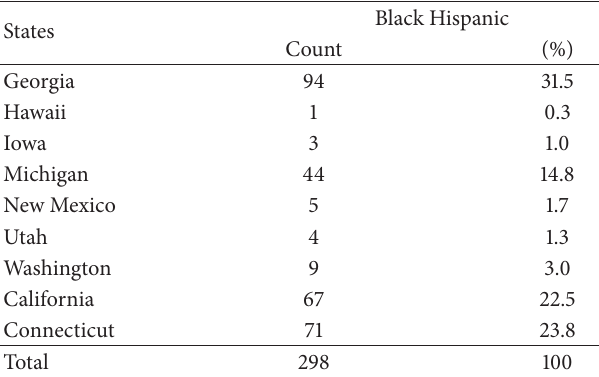
Figure 2: The nine states from which the Black Hispanic breast cancer patients were selected. Note . The Black Hispanic females ( 𝑛 = 298 ) patients were randomly selected from the dark blue colored nine states in Figure 2. Table 1: Frequency distribution of the selected Black Hispanic breast cancer patients from the nine states.